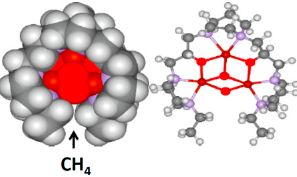
Figure 16. The Cu I3 L complex in mesoporous silica gel for the transformation of methane to methanol using hydrogen peroxide under room temperature (Liu et al., 2016) [134].